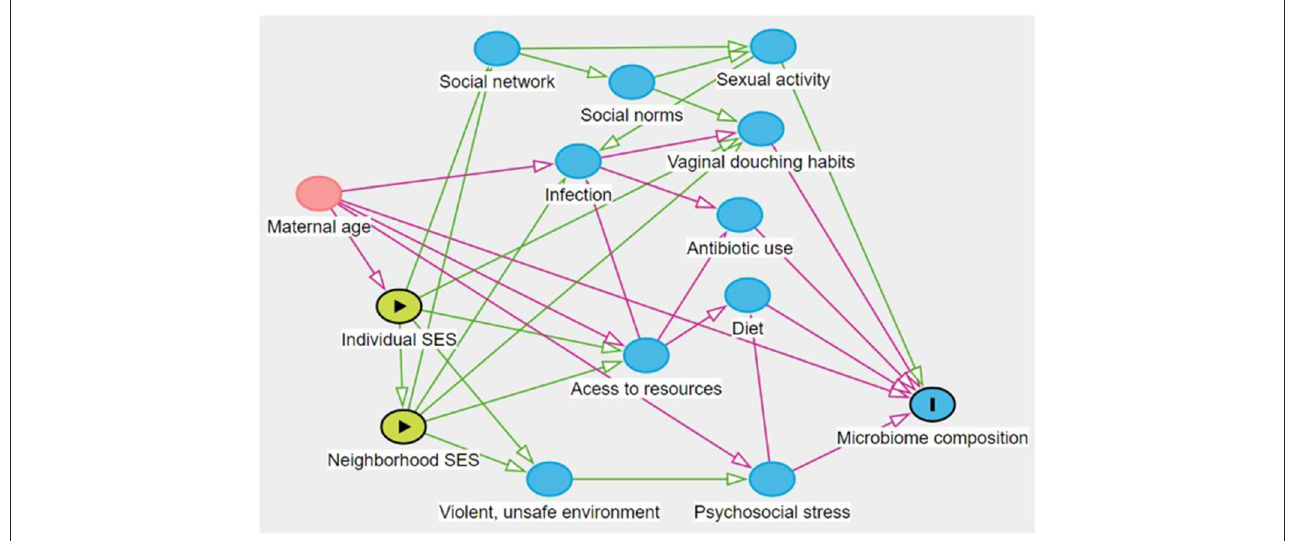
FIGURE1 Hypothesized causal structure. This figure created at http://www.dagitty.net/ (41).